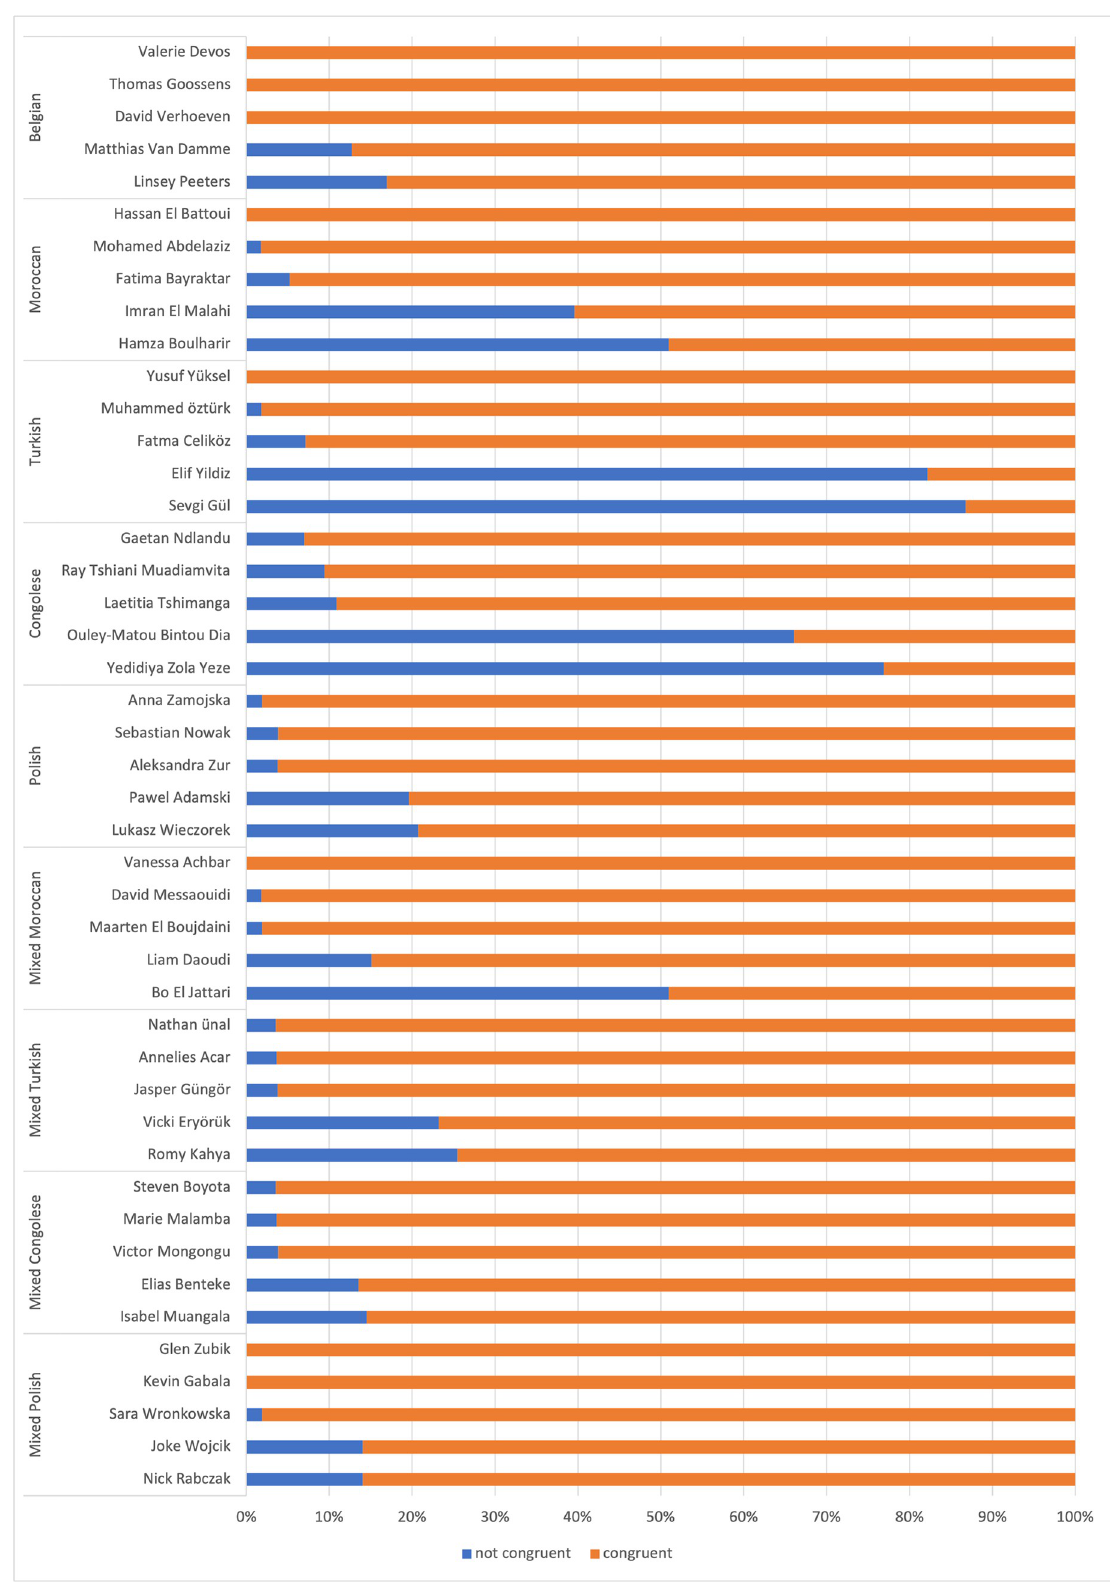
Fig 2. https://doi.org/10.1371/journal.pone.0270990.g002 PLOS ONE | https://doi.org/10.1371/journal.pone.0270990 August 2,